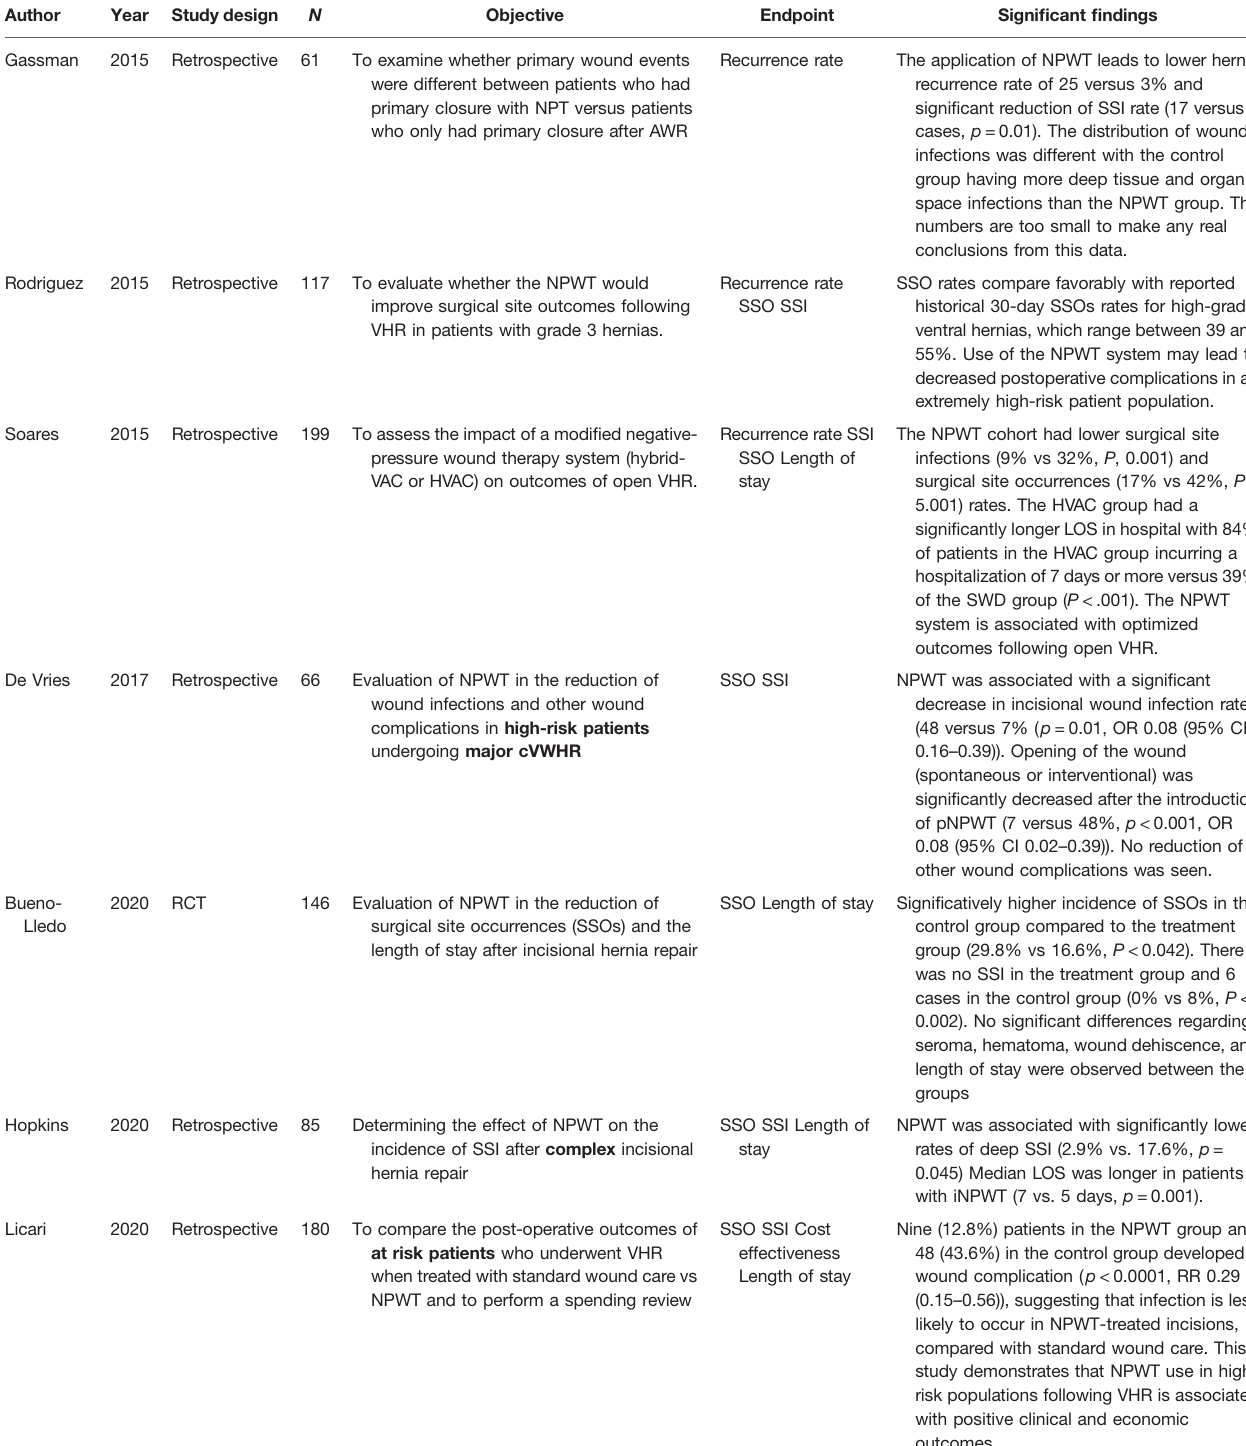
TABLE 3 | Overview of results